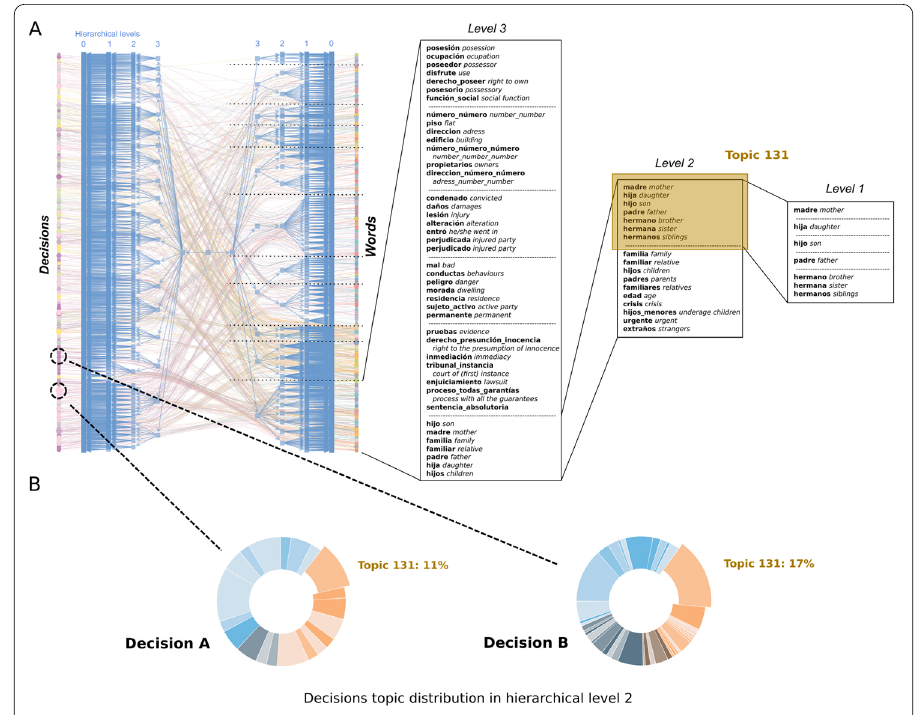
Figure 2 Hierarchical topic models and decisions as distributions over topics. ( A ) Using a network-based topic modeling approach that uses hierarchical stochastic block models [29], we infer hierarchical partitions in the bipartite network of judicial decisions and words. We show word topics in the housing decisions corpus. The hierarchical structure of the model is illustrated by expanding a particular topic: from left to right, we take a topic at the highest level of the hierarchy (level 3) and expand specific sub-topics at successively lower levels. (At level 3, only the top words in each subtopic are shown.) Topics contain words that are used in similar contexts, and this similarity increases as we go down in the hierarchy. ( B ) Given the membership of each word in a given topic, decisions can be characterized as distributions over topics by measuring the number of times each word appears in a document (Section 2). For example, topic 131 accounts for 11% of the words in Decision A, and for 17% of the words in Decision B. We follow the same procedure for